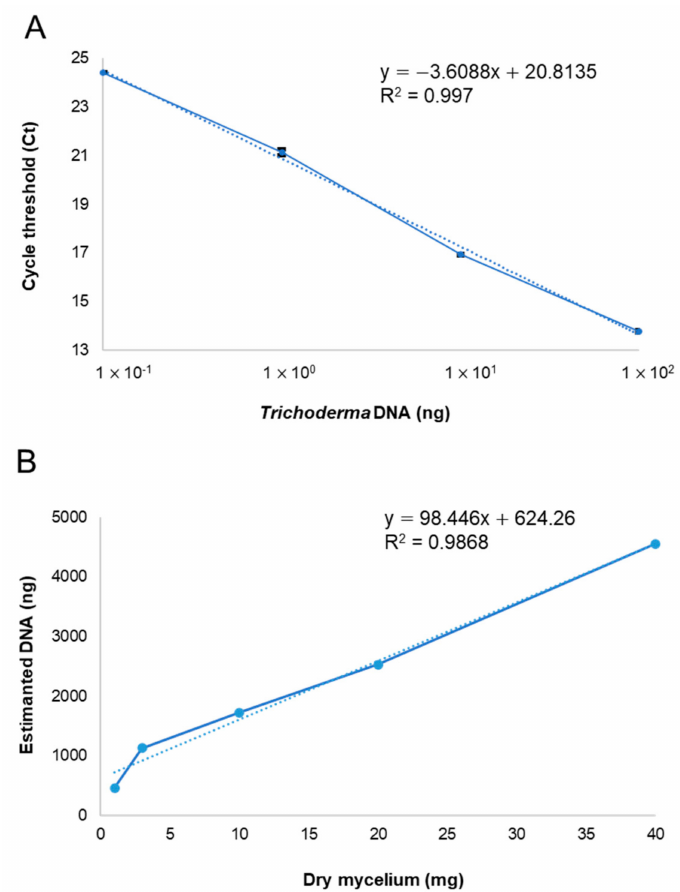
Figure 3. ( A ) Standard curve of Trichoderma atroviride Ta13 DNA concentration standards vs. cycle threshold (Ct) to quantify Trichoderma spp. using the TCal primer pair. ( B ) Linear relation between the T. atroviride Ta13 mycelial weights and the DNA estimation. Each PCR reaction was performed in three biological and technical replicates and a no-template